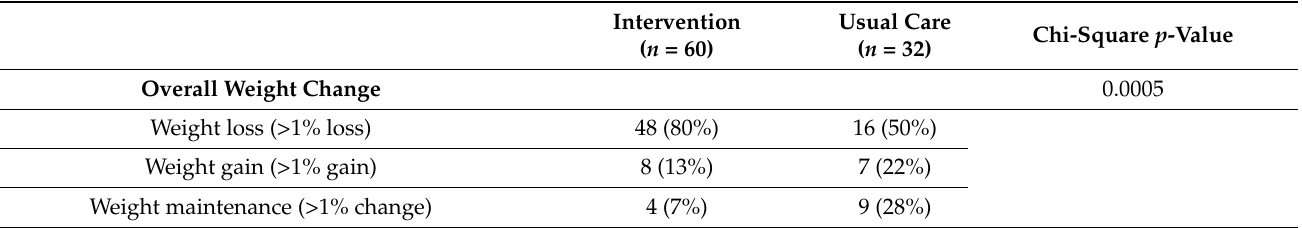
Table 3. Post-study weight change stratified by weight changes at the end of six-month study.